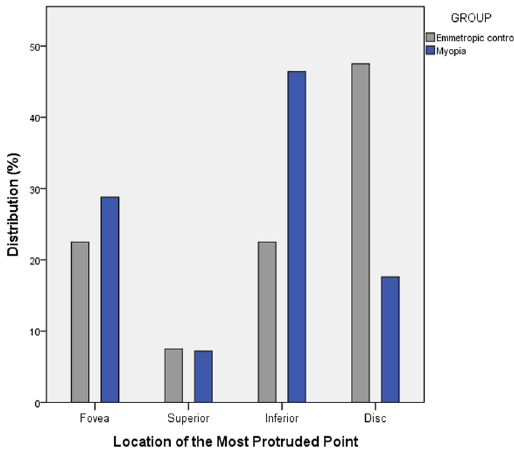
Figure 4. Histogram showing the distribution of the location of the most protruded point (MPP). In the emmetropic controls, the MPP was located near the optic disc (47.5%), followed by fovea, inferior, and superior (22.5%, 22.5%, and 7.5%, respectively). In the myopic group, in most eyes, the MPP was at the inferior (46.4%) followed by the fovea, disc, and superior (28.8%, 17.6%, and 7.2%, respectively). The two groups were significantly different ( P = 0.001).